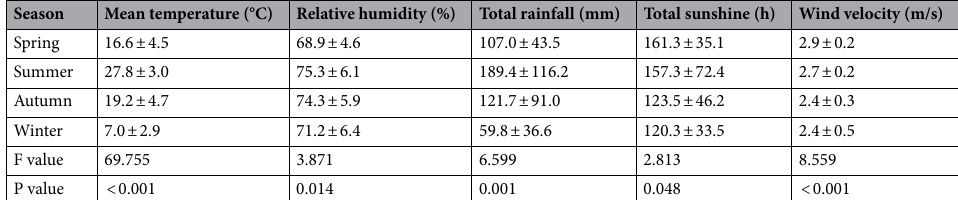
Table 2. Seasonal average concentrations of meteorological factors in Suzhou area from 2013 to 2017 ( x ± s).